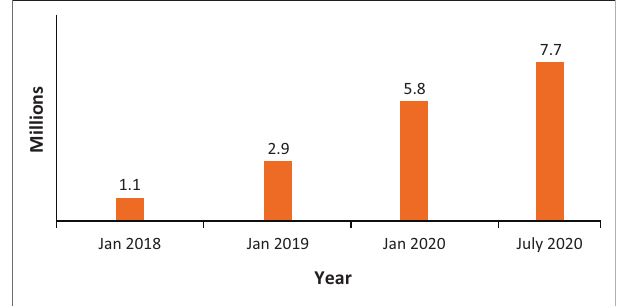
FIGURE 3: Food-insecure population over a period of 3.5